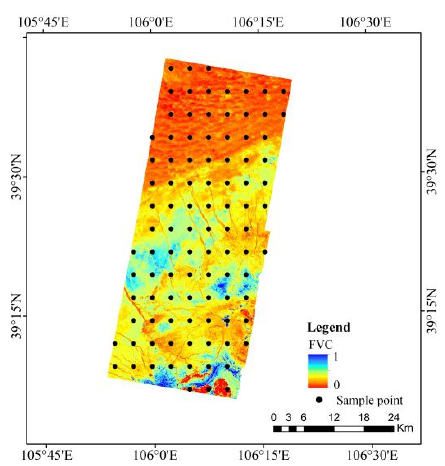
Figure 11. Distribution of vegetation coverage and sample points.